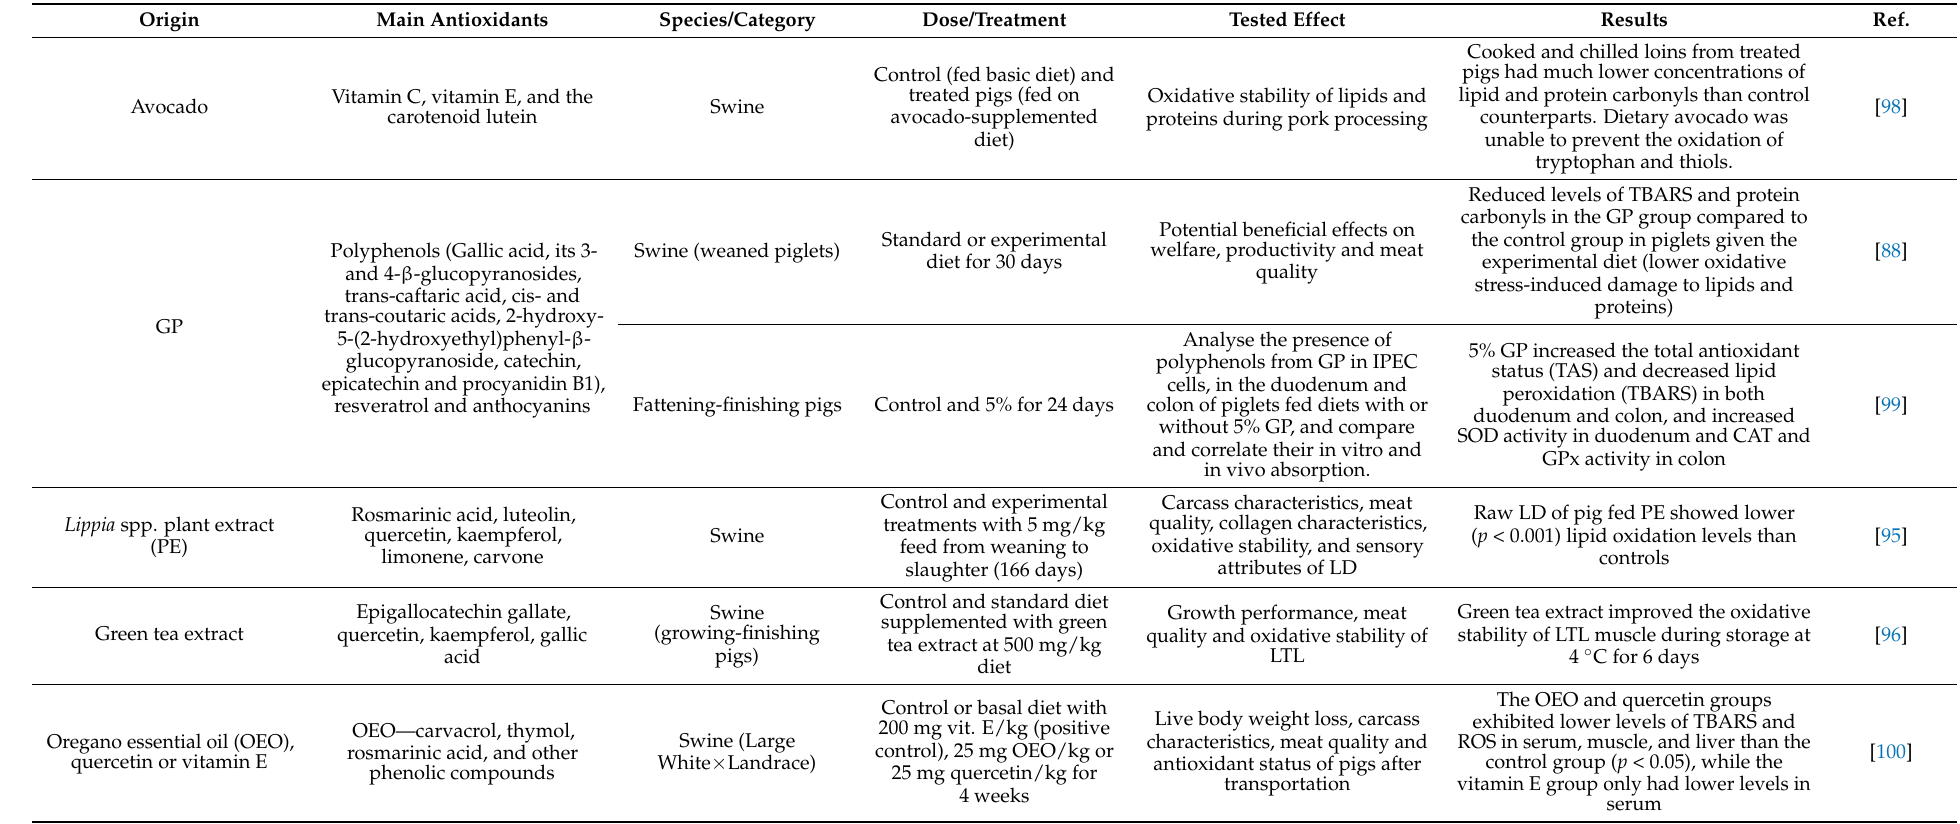
Table 3. Literature review on the effects of some natural antioxidant sources by diet supplementation in